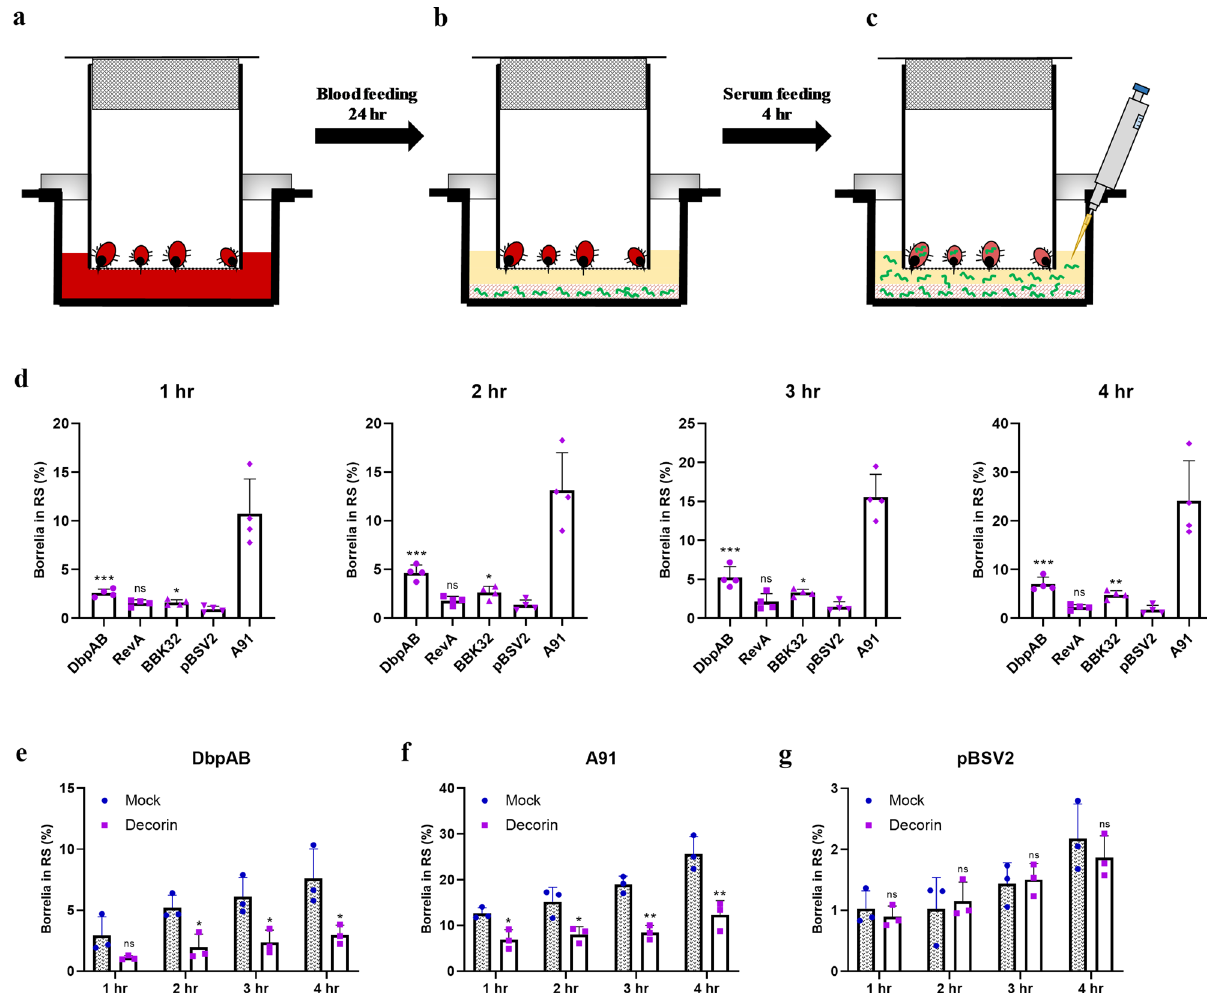
Fig. 2 DbpAB expression strongly enhances the number of spirochetes reaching blood serum upon feeding. a – c Schematic design of the ECM motility assay that imitates the period before B. burgdorferi acquisition by ticks. Tick feeding was induced by placing the ticks on fresh rabbit blood for 24 h ( a ). Borrelia was embedded in the ECM gel and overlaid with rabbit serum (RS) ( b ). Ticks were allowed to feed and samples of RS were collected in duplicates (2 × 200 μ L) at 1-h interval, in total for 4 h ( c ). d The number of spirochetes that reached RS was monitored over time using qPCR and the in fl uence